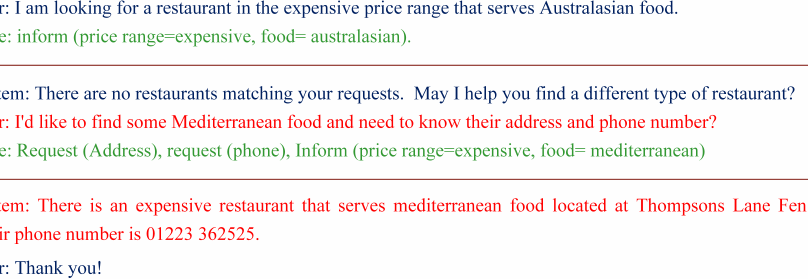
Figure 2. A toy example of dialogue conversation based on WoZ-2.0